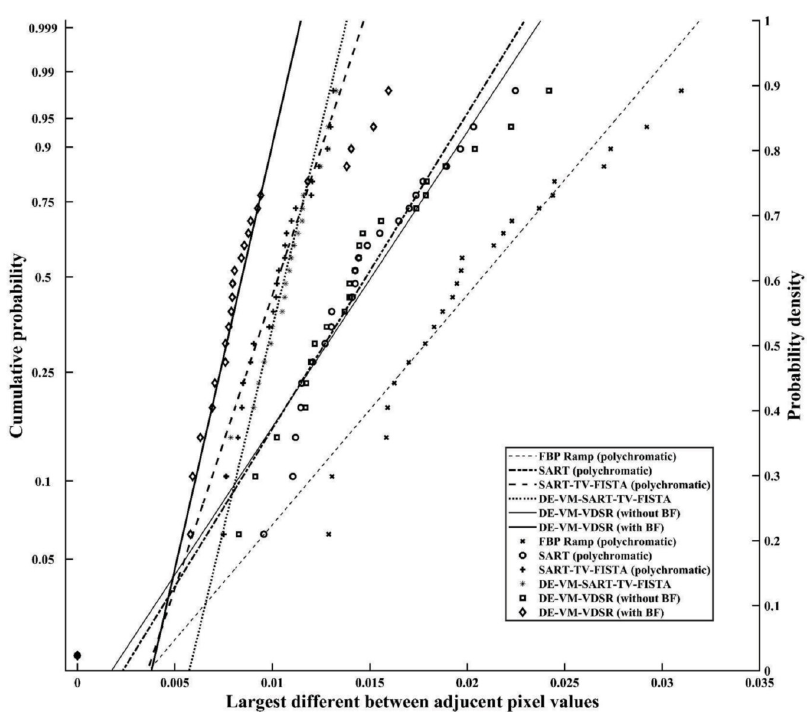
Fig 11. The largest variations extracted from 23 pixel-value profiles are plotted. The relatively large variations in pixel values were attributed to high-frequency ripple